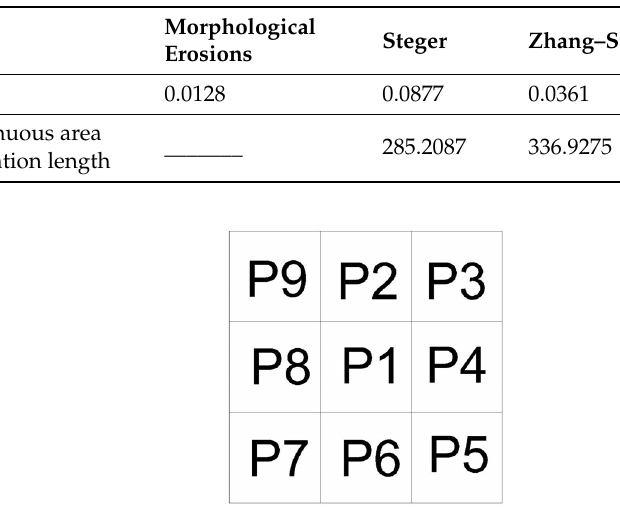
Table 3. Comparison of the results.